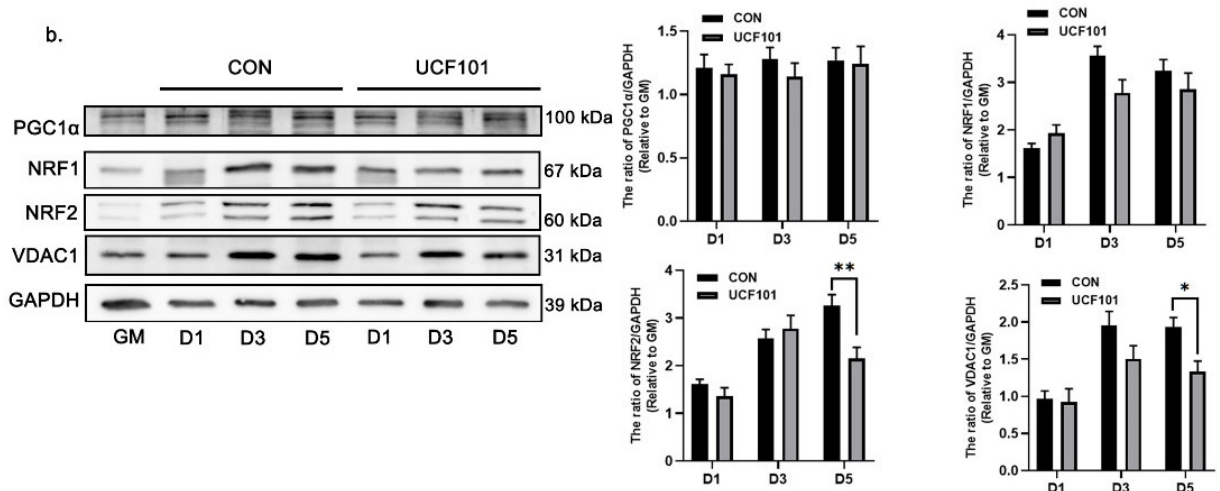
Figure 5. Expression levels of ETC complex subunits and PGC1-NRF1/2 signaling pathway proteins during differentiation of C2C12 myoblasts. ( a ) Western blot of ETC complex subunits ND1, CYTB, ATP6A1, SDHA, and COXIV in C2C12 cells during differentiation on D1, D3, and D5 after treatment with UCF101 (20 μM) or no treatment and quantification of Western blots relative to GM ( n = 3). ( b ) Western blot of PGC1α, NRF1, NRF2, and VDAC in C2C12 myoblasts at differentiation on D1, D3, and D5 after treatment with UCF101 (20 μM) or no treatment and quantification of Western blots relative to GM ( n = 3). Two-tailed unpaired Student’s t -tests were used. Statistical significance: * p ≤0.05, ** p ≤0.01. ND1, NADH1; SDHA, succinate dehydrogenase complex flavoprotein subunit A; COXIV, cytochrome c oxidase subunit 4; CYTB, cytochrome b; ATP6, ATP synthase F0 subunit 6.